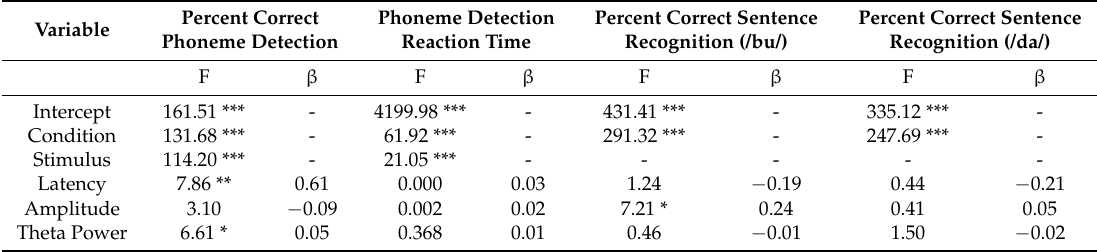
Table 4. F-statistics and regression coefficients ( β ) for fixed effects from linear mixed-effects regression models for each behavioral measure (Koerner et al.